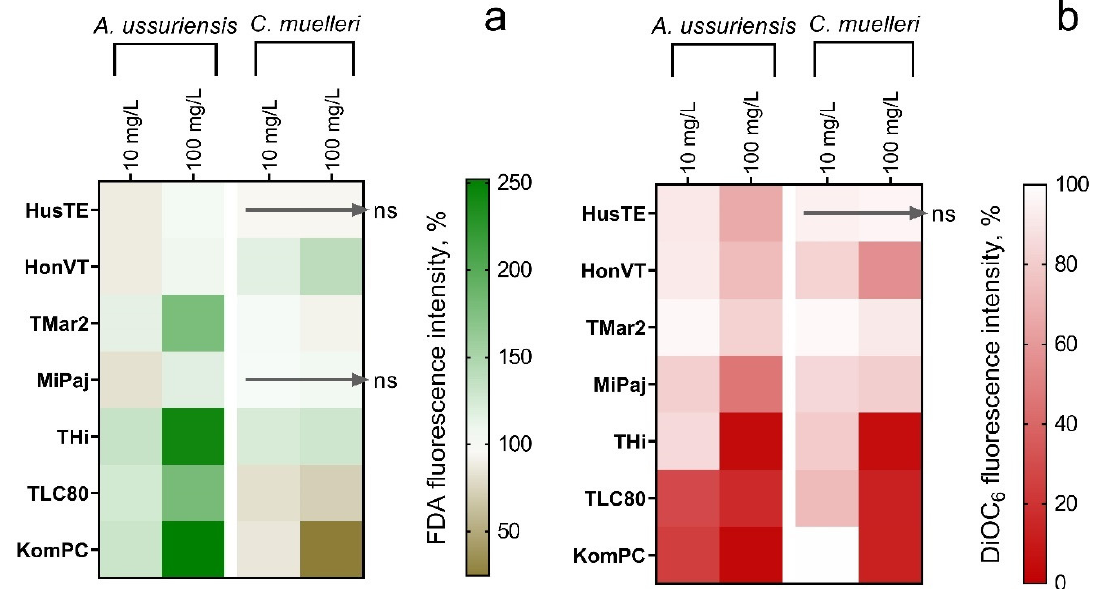
Figure 3. The changes in esterase activity and membrane polarization of the diatomic microalgae A. ussuriensis and C. muelleri after 24 h of exposure to the VEPs, ( a ) Esterase activity changes; ( b ) membrane polarization changes. ns, the tested sample had no significant effect on the esterase activity or membrane potential of microalgae cells ( p < 0.05). The concentration of 1 mg/L of all the tested samples had no significant effect on the esterase activity and membrane potential of microalgae (not represented on the